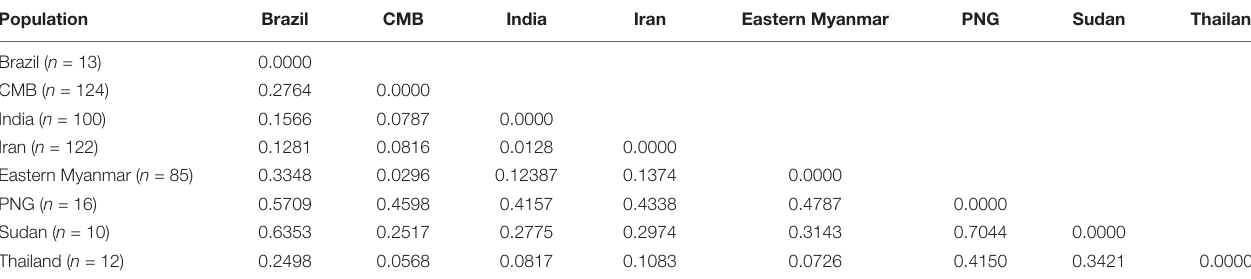
FIGURE 4 | Linkage disequilibrium (LD) plot showing non-random association between nucleotide variants among 124 CMB P. vivax isolates at different polymorphic sites. (A) The significant LD sites detected by Fisher’s exact test are marked red pots and others are marked blue pots. The dashed line represents the regression. (B) R 2 for each pair of genetic polymorphisms of CMB isolates. TABLE 3 | Estimation of genetic differentiation (Fst) of the pvdbp -II among other geographical